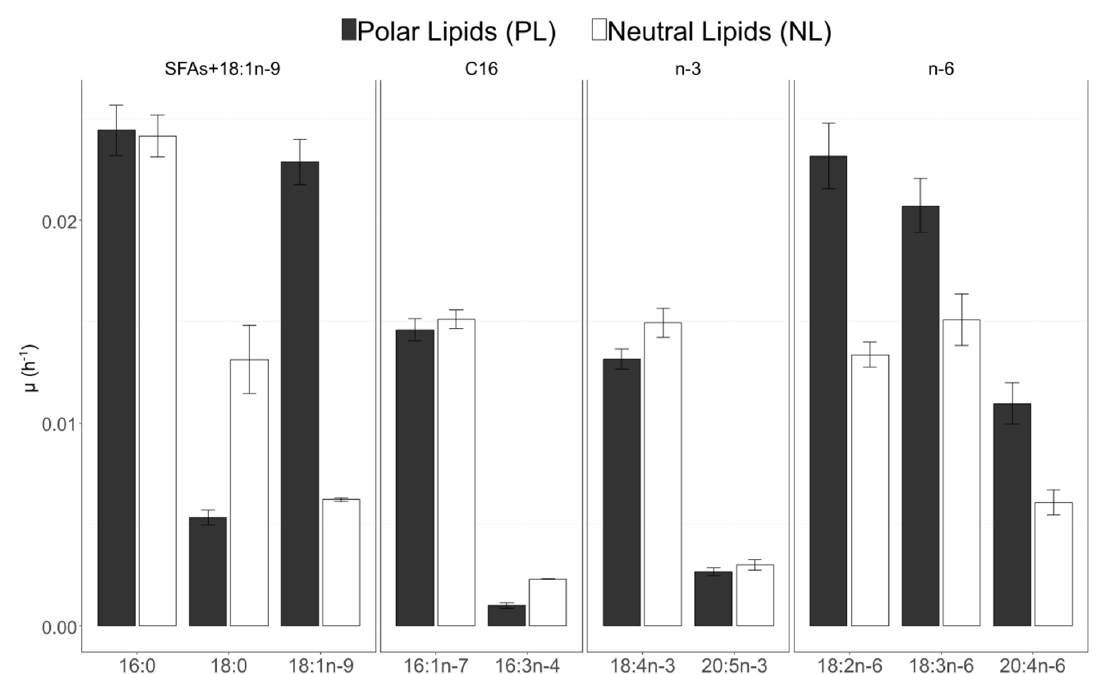
Figure 10. Specific uptake rates calculated with AE ( µ FA ) of the 10 studied fatty acids in polar lipids (PL) and neutral lipids (NL) of C. muelleri (n = 2 for each). Mean ratio of atomic enrichment (AE) for pairs of FA were calculated for neutral lipids (NL) and polar lipids (PL) to explore the precursor–product relationship between FA (Figure 10). For the C 16 pathway and connections between n-3 and n-6 pathways, all the ratios are below 1 for NL and PL (Table 4). It was also the case for 20:5n-3/18:4n-3 in PL and NL in the n-3 pathway,